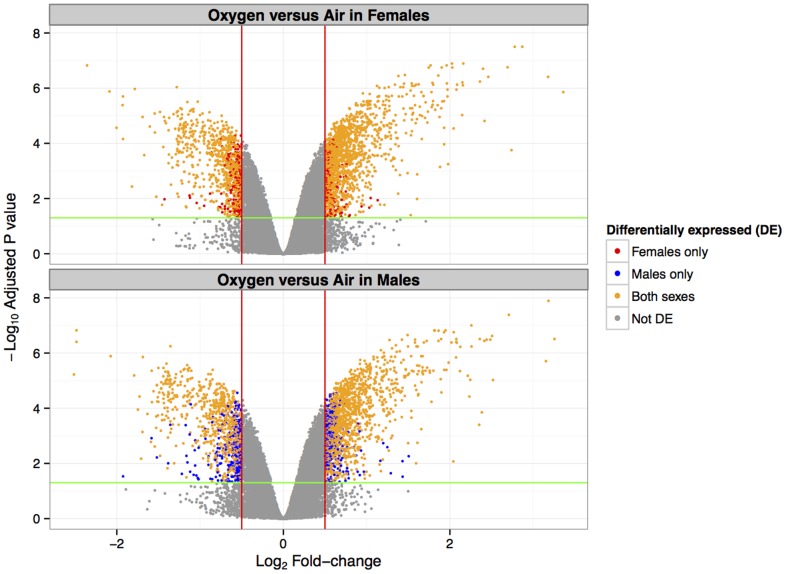
Volcano plot for differentially expressed genes in male and female mice after hyperoxia (FiO2>95%) exposure for 48 h compared to room air controls.The x-axis is log2fold change. Each point represents an individual transcript. The vertical lines represents 1.4 fold change with upregulated genes on the right and downregulated genes on the left. The horizontal lines represent an adjusted p value of 0.05.